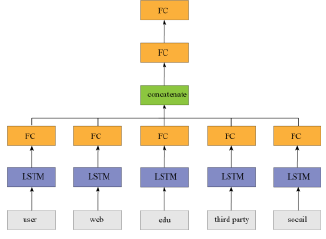
Fig. 3. Investors structure of project. Fig. 4. Network model